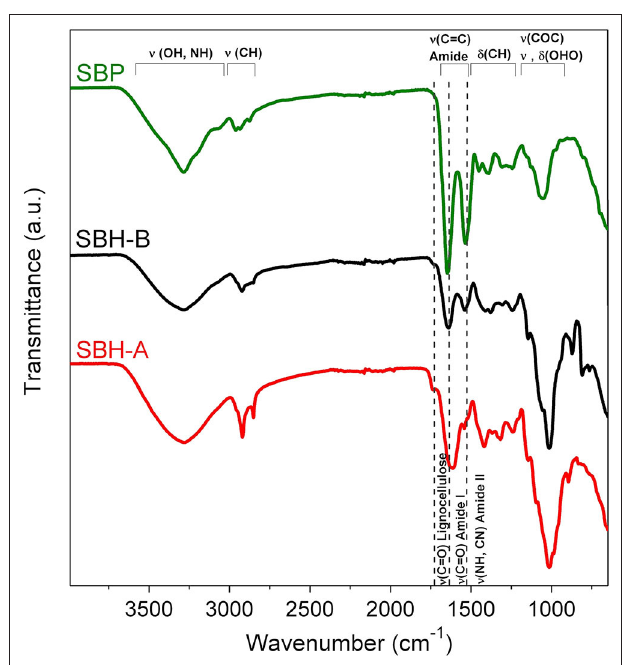
FIGURE 2 | ATR-FTIR spectra of SBP commercial sample, SBH-B and SBH-A. Main vibrational modes observed in the spectra are indicated in the figure.